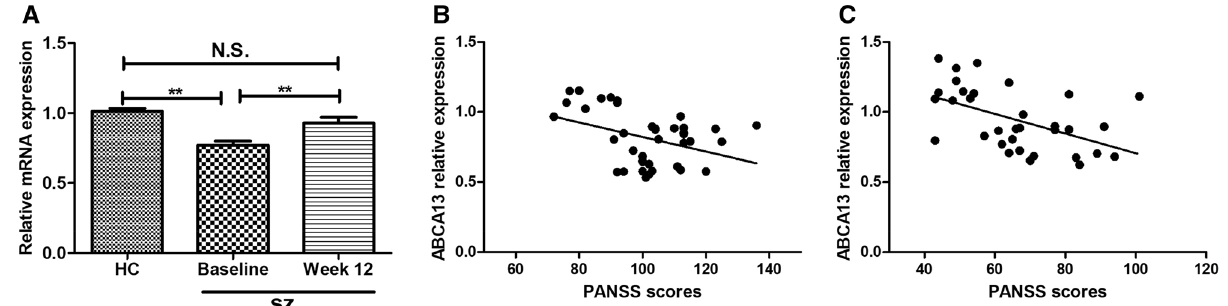
Figure 1. ( A ) ABCA13 relative expression levels in the healthy controls and the SZ patients at baseline and 12-week follow-up. ( B ) Scatter plot and regression line of ABCA13 relative expression levels and PANSS scores at baseline. ( C ) Scatter plot and regression line of ABCA13 relative expression levels and PANSS scores at 12-week follow-up. HC healthy controls, SZ schizophrenia, PANSS Positive and Negative Syndrome Scale. ** P <